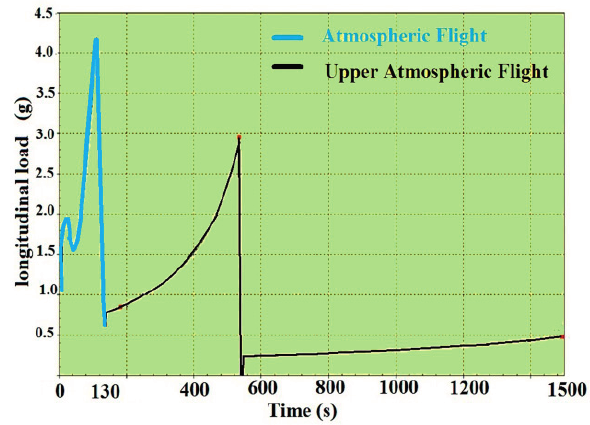
Figure 10. Longitudinal steady-state acceleration of the Ariane 5 launch vehicle, adapted from